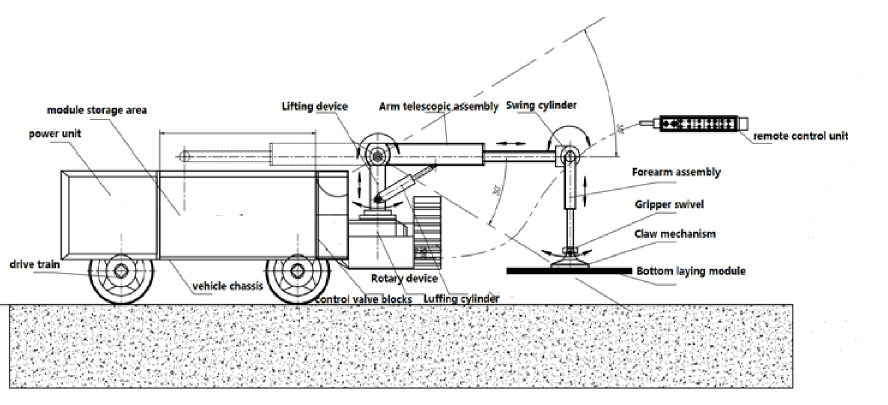
Fig. 1. An automatic bottom laying